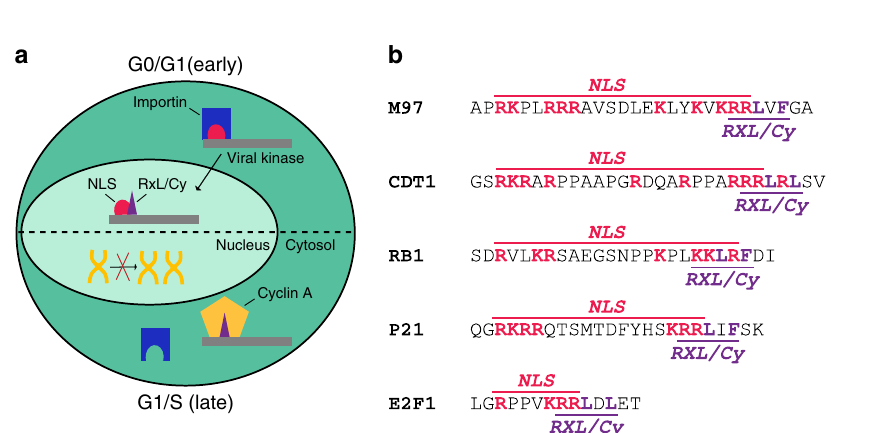
Fig. 6 The NLS-RXL module is conserved across several cell cycle regulators. a A model summarizing the function of the NLS-RXL/Cy module in infected cells. In the absence of Cyclin A (G0/G1, early), the NLS of M97 is functional and M97 is imported into the nucleus. MCMV induces Cyclin A and drives the cell cycle towards an S-phase environment (G1/S, late). Cyclin A binds to the RXL/Cy motif on M97 and masks the NLS, leading to cytosolic accumulation of M97 – Cyclin A complexes. Cellular DNA synthesis is inhibited due to mislocalized Cyclin A. b Conservation of RXL/Cy-NLS modules across several cellular cell cycle regulatory proteins. The depicted sequences are of human adsorption period of 30min, cell cultures were centrifuged for 30 min at 1000 g . Then, the virus inoculum was replaced by fresh medium. Virus titers were deter- mined by fl ow cytometry of IE1 fl uorescent cells at 6h post infection or by using the median tissue culture infective dose (TCID 50 ) method. Unless otherwise stated, a multiplicity of infection (MOI) of 5 IE protein forming units (IU) per cell was used for experiments. Bacmids . MCMV-HA-M97 and MCMV-M97-K290Q have been described recently 23 . R45A/L47A, L47A/F49A, and M1STOP mutations were introduced into MCMV-HA-M97 by traceless BAC mutagenesis 67 . The oligonucleotide primers used for BAC mutagenesis are speci fi ed in Supplementary Data 5. All mutants were controlled by diagnostic PCR and sequencing (Supplementary Fig. 5). To recon- stitute infectious virus, BACs together with pp71 expression plasmid were trans- fected into 3T3 fi broblasts using an Amaxa nucleofector (Lonza). Plasmids . PCGN-based expression plasmids for HA-tagged HHV1-UL13, HHV3- ORF47, HHV4-BGLF4, HHV5-UL97, HHV6-U69, HHV7-U69, and HHV8- ORF36 (Addgene plasmids #26687, #26689, #26691, #26693, #26695, #26697, #26698) were gifts from Robert Kalejta 13 . PCIneo-3HA-M97 was used as expres- sion plasmid for HA-tagged M97 (ref. 23 ). RXL/Cy mutations were introduced by site-directed inverse PCR-mutagenesis (primers, see Supplementary Data 5). PHM830 (Addgene plasmid #20702) was a gift from Thomas Stamminger 36 . Fragments encompassing the NLS-RXL/Cy modules of M97 and U69 were PCR- ampli fi ed and cloned between NheI and XbaI sites of pHM830 (primers listed in Supplementary Data 5). Plasmids were con fi rmed by Sanger sequencing and puri fi ed by cesium chloride-ethidium bromide equilibrium centrifugation. PEI MAX (Polysciences), transfection grade linear polyethylenimine hydrochloride with a molecular weight of 40kDa, was used for transfection. Phosphopeptide enrichment . SILAC-labeled cells were harvested 24 h post Biotec) was employed according to the manufacturer ’ s instructions, with the fol- MCMV infection via scraping. Cells were lysed with 6M urea/2 M thiourea in lowing modi fi cations. Lysates were incubated with the magnetic beads for 1 h and 0.1M Tris-HCl, pH 8.0. Samples were reduced with 10 mM dithiothreitol (DTT) SILAC labels were mixed right before the lysates were applied to the column. Lysis and alkylated with 50 mM iodoacetamide for 30 min in the dark. Proteins were buffer was used for the fi rst washing step, lysis buffer without detergent for the